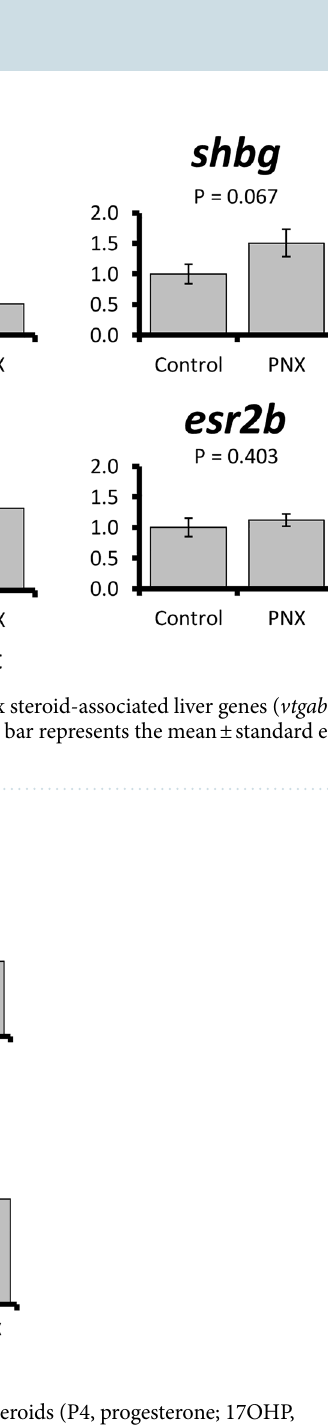
Figure 7. Blood plasma concentrations (ng/μl plasma) of six steroids (P4, progesterone; 17OHP, 17-hydroxyprogesterone; CORT, corticosterone; F, cortisol; T, testosterone; 11-KT, 11-ketotestosterone). Each bar represents the mean ± standard error and the asterisk indicates significance (P =